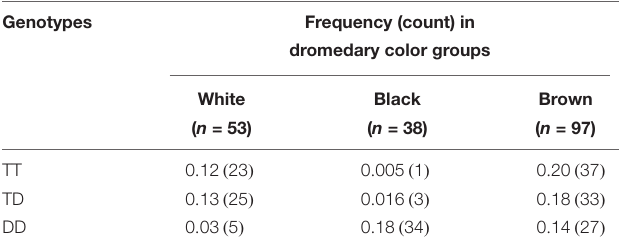
TABLE 7 | Genotype frequencies of ASIP exon 2 g.174495T_del (D) nonsense mutation in a large study cohort ( n = 188).